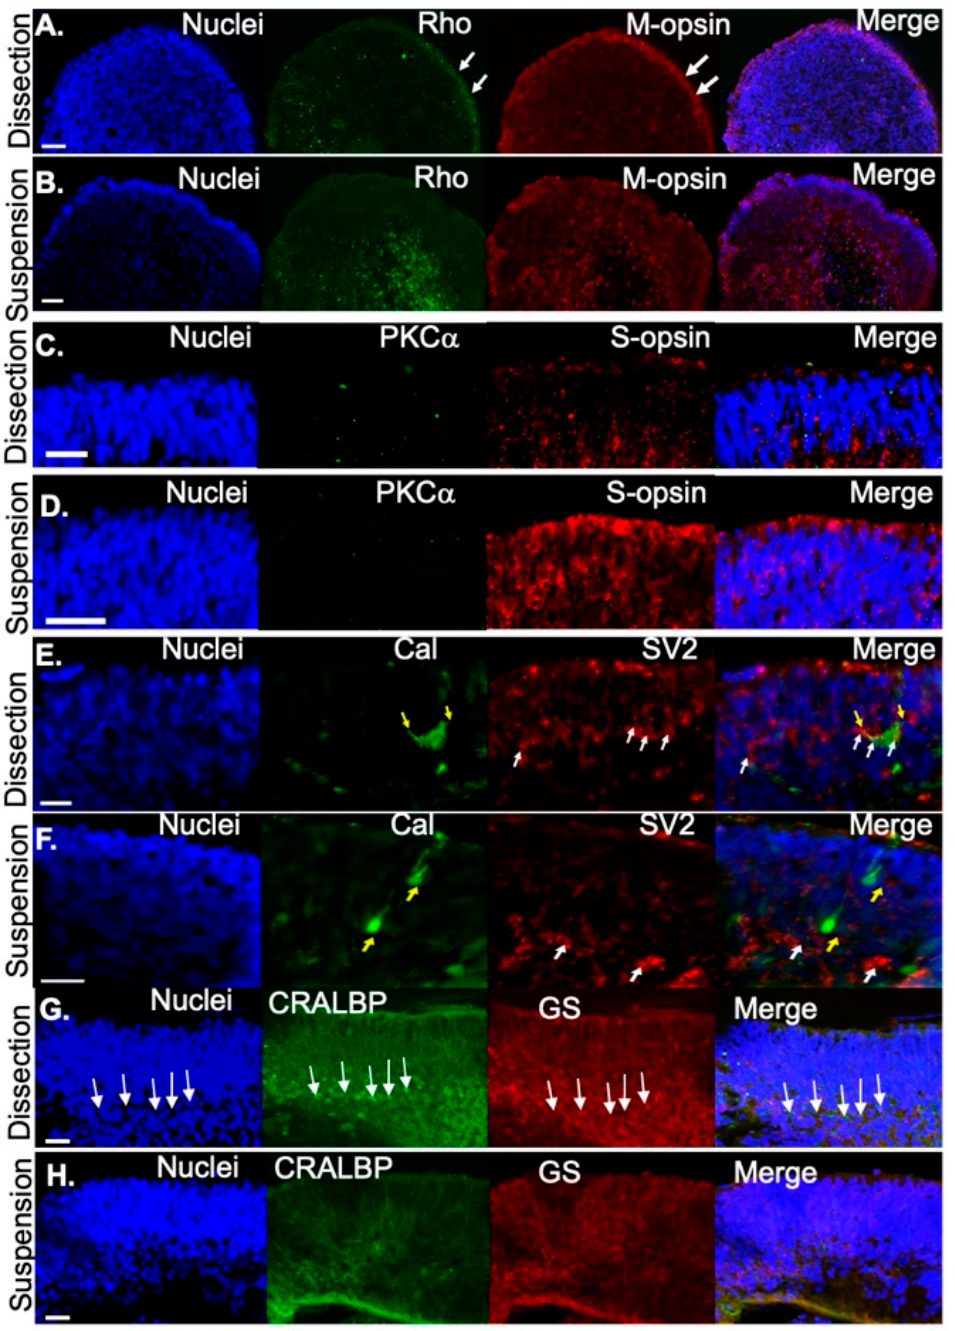
Figure 4. Retinal organoids express photoreceptor proteins at D120. ( A ) Rhodopsin (Rho) and M-opsin were correctly localized to the outer rim in dissected retinal organoids but Rho and M-opsin was centrally or diffusely localized, respectively in ( B ) suspension retinal organoids. S-opsin was rarely detected in ( C ) dissected retinal organoids but was ( D ) localized to the putative outer segments for those grown under suspension. ( E ) Yellow arrows highlight horizontal cells (Calbindin, Cal, green) with processes reaching out to photoreceptor terminals (white arrows, SV2, red). ( F ) Yellow arrows highlight horizontal cells (Cal, green), exhibiting a vertical alignment without connection to the photoreceptor terminals (SV2, red). ( G ) Müller glial cells were identified with CRALBP (arrows) and GS in dissected retinal organoids and to a lesser extent in ( H ) suspension-grown retinal organoids. Scale bars 20 μ m.